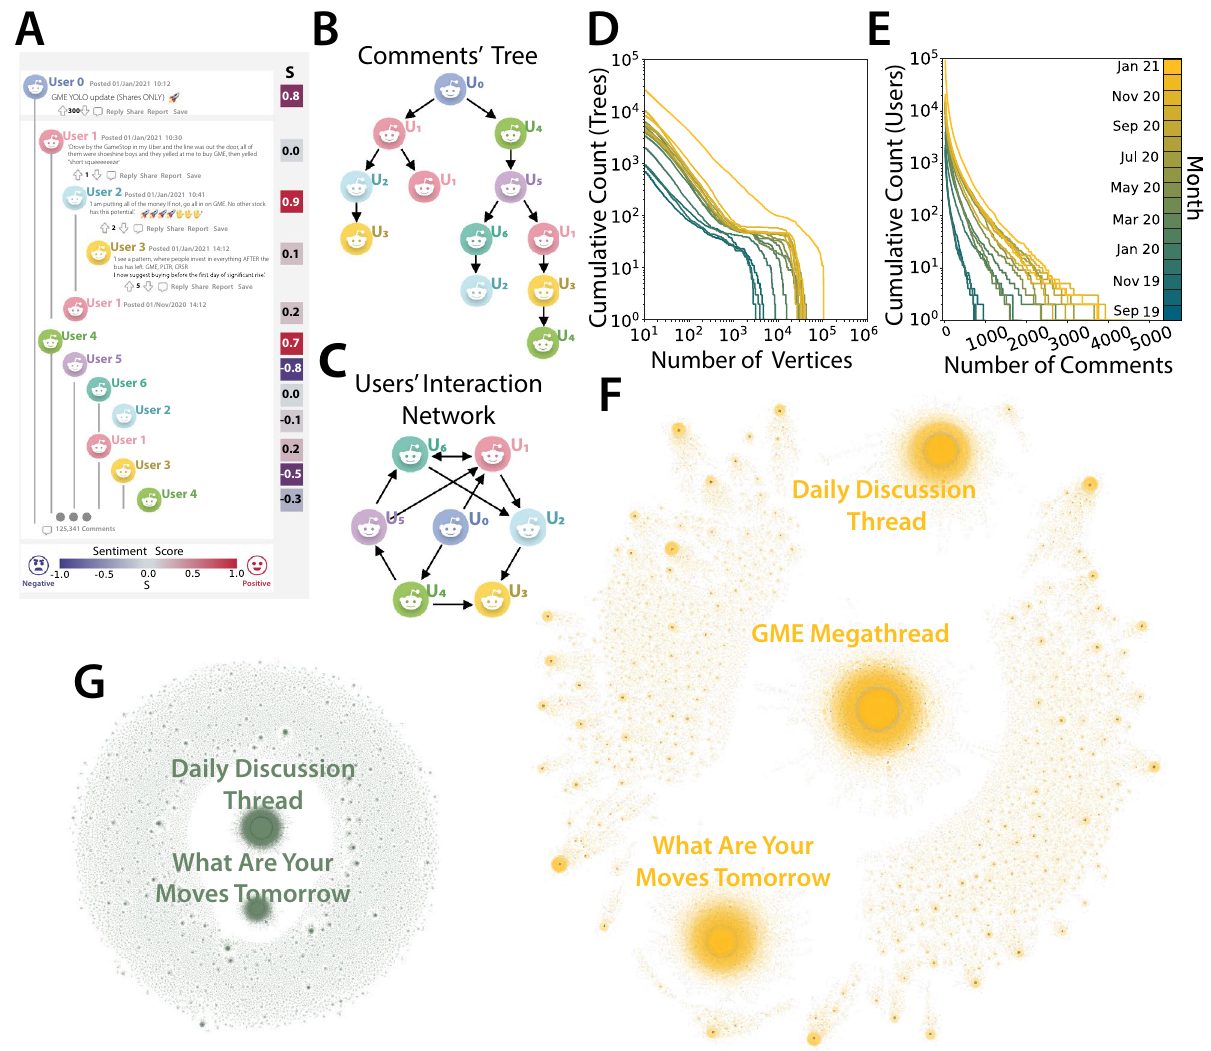
Figure 1. Tree structure of Reddit conversations. ( A ) Reddit users can write posts to initiate a conversation and can comment (reply) to posts or other comments. A sentiment score between − 1 and + 1 (negative and positive, respectively) can be computed for each post and comment. ( B ) The conversation on the social network can be represented by a forest of trees , where each post is the root of a tree and subsequent comments represent its branches. ( C ) Trees can be used to extract a user-user network, where a link from user i to user j represents the number of times i commented to posts/comments by user j . ( D ) Cumulative count of trees larger than a given size (in terms of number of comments) for different months in the considered time span of data. ( E ) Cumulative count of users that contributed more than a given number of posts/comments during different months. ( F , G ) Sample representation of the forest of tree conversations for January 21, 2021 and March 19, 2020, respectively. Icons in ( A – C ) have been designed by Freepik. The schematic representation of a reddit post in ( A ) has been recreated by the authors. The network representations on ( F , G ) have been created by the authors using the software